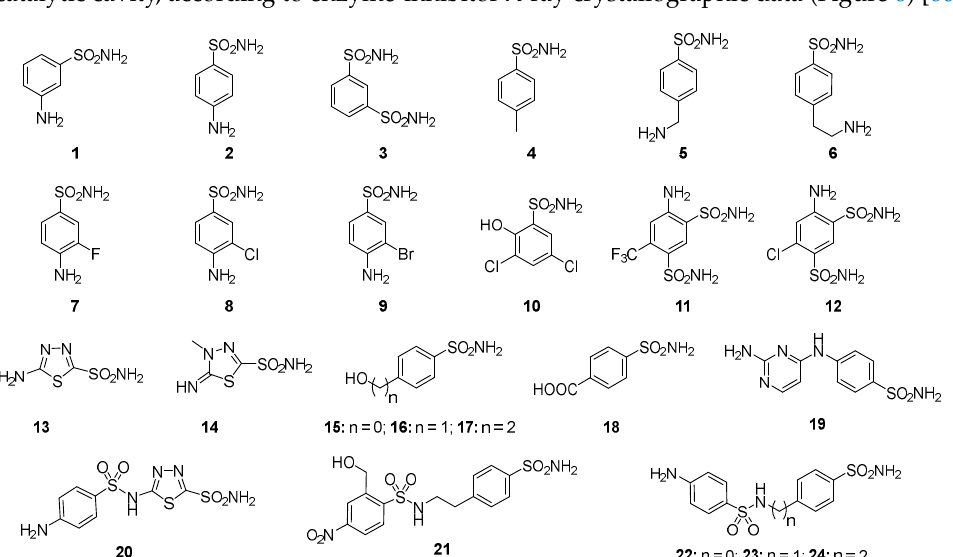
Figure 5. Structure of clinically used sulfonamide/sulfamate/sulfamide derivatives AAZ-HCT.